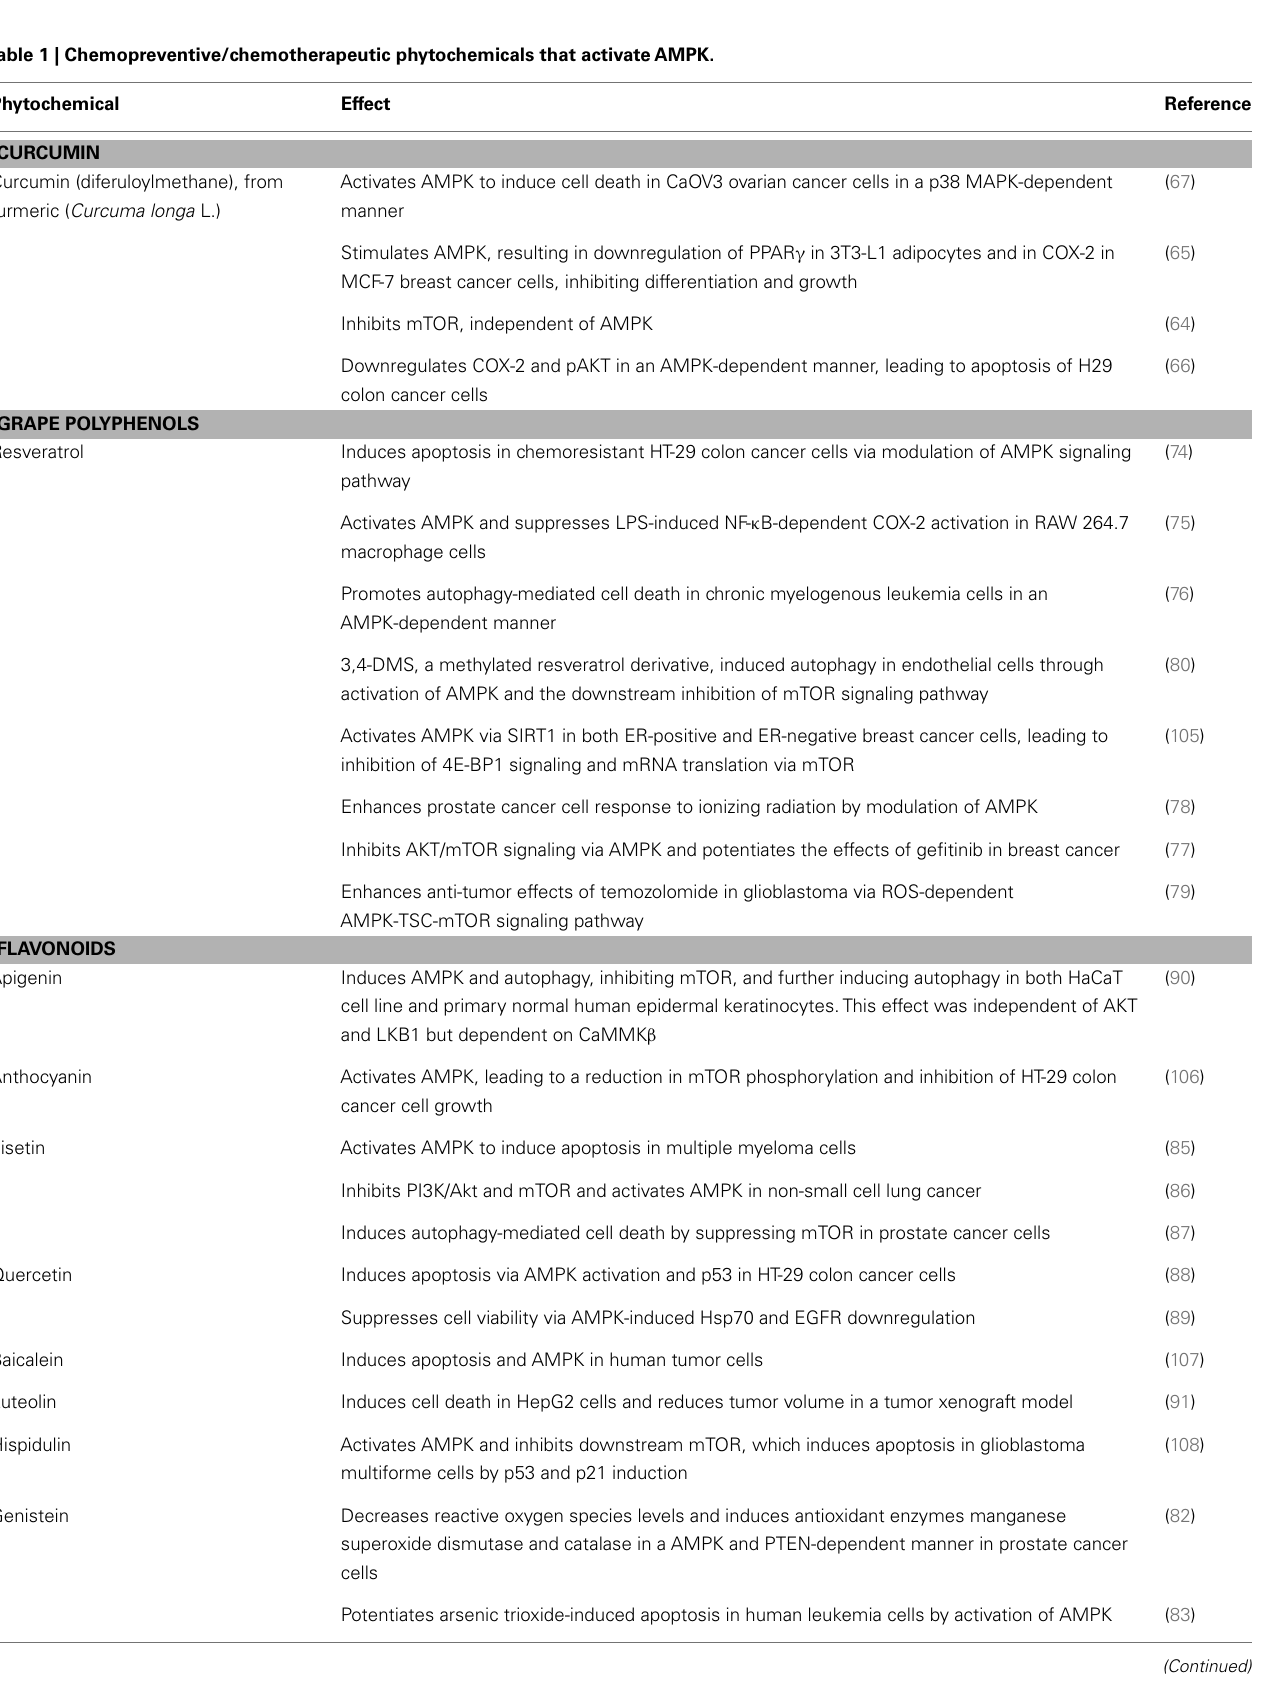
Table 1 | Chemopreventive/chemotherapeutic phytochemicals that activateAMPK.